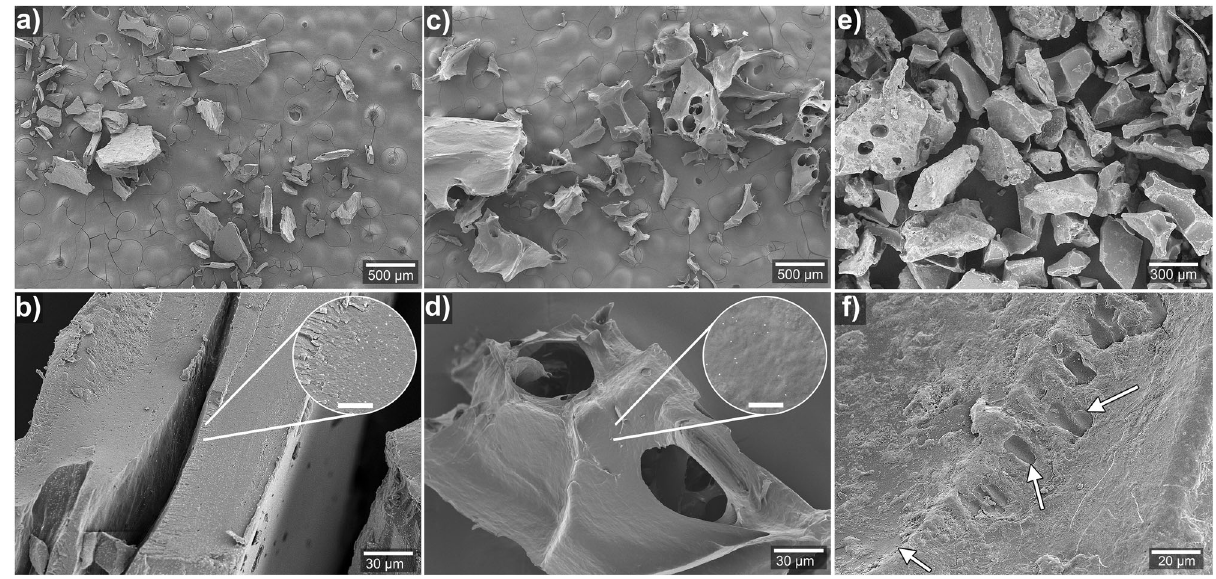
Fig. 3 Particle morphologies. a , b , Dry PPC/25ED particles. c , d , Lyophilised PPC/25ED foam-like particles after 24 h in MQw. The scale bar in the inset of b and d is 2.5 µ m. e , f , Images of commercial SAP particles. The arrows in f point at the smooth-surface regions on the surface of the particles.